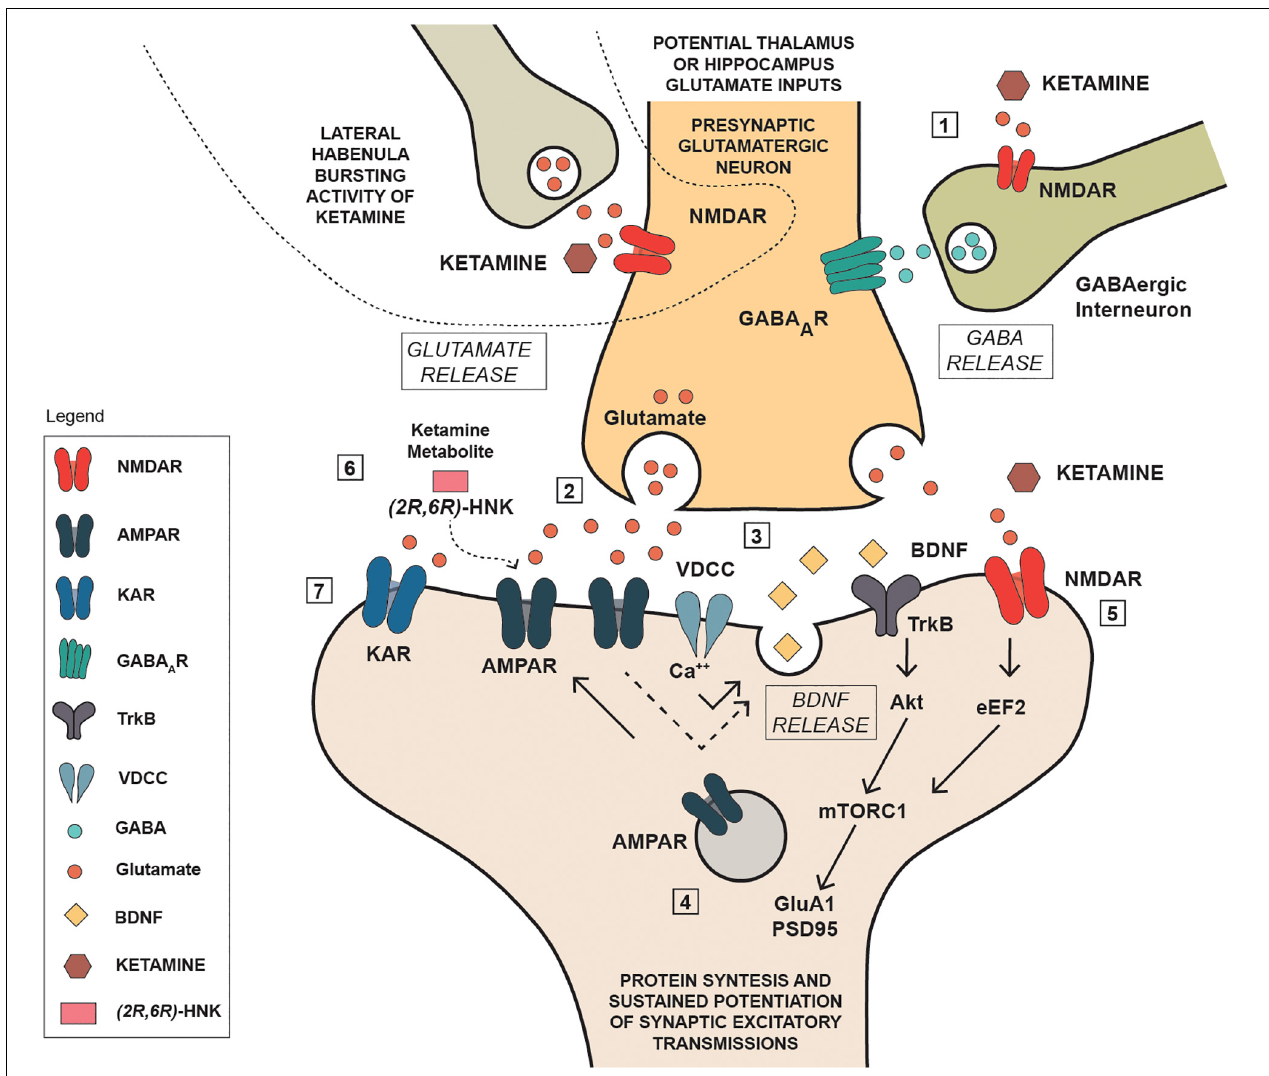
FIGURE 2 | Schematic representation of some potential mechanisms involved in the antidepressant actions of ketamine. (1): Ketamine reduces NMDA receptor mediated stimulation of GABA interneurons reducing the inhibitory action on presynaptic glutamatergic neuron; (2) the reduced inhibition produces a rapid glutamate burst acting on AMPA receptors located on pyramidal neurons; (3) Such activation leads to the opening of voltage-dependent calcium channels (VDCC) that stimulate BDNF; (4) BDNF induce the translation and synthesis of key synaptic proteins in synaptogenesis and maturation of dendritic spines, including GluA1 and PSD95), via the TrkB/Flk-1 - mTORC1-signaling pathway; (5) ketamine acting as NMDA inhibited the eukaryotic elongation factor2 (eEF2) kinase, resulting in reduced eEF2 phosphorylation and increased BDNF translation and protein synthesis; (6) ketamine metabolite can stimulate AMPA receptors independently of